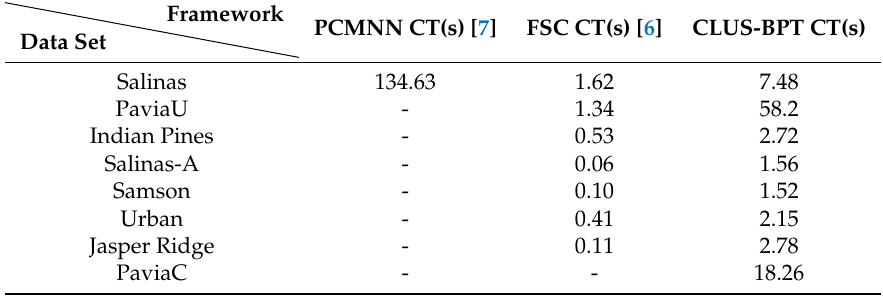
Figure 10. Computational time measured at different number of regions N P Table 3. Computational time for projected clustering using mutual nearest neighbor (PCMNN), fast spectral clustering (FSC), and clustering using BPT (CLUS-BPT) obtained for the best purity and NMI results for hyperspectral image data